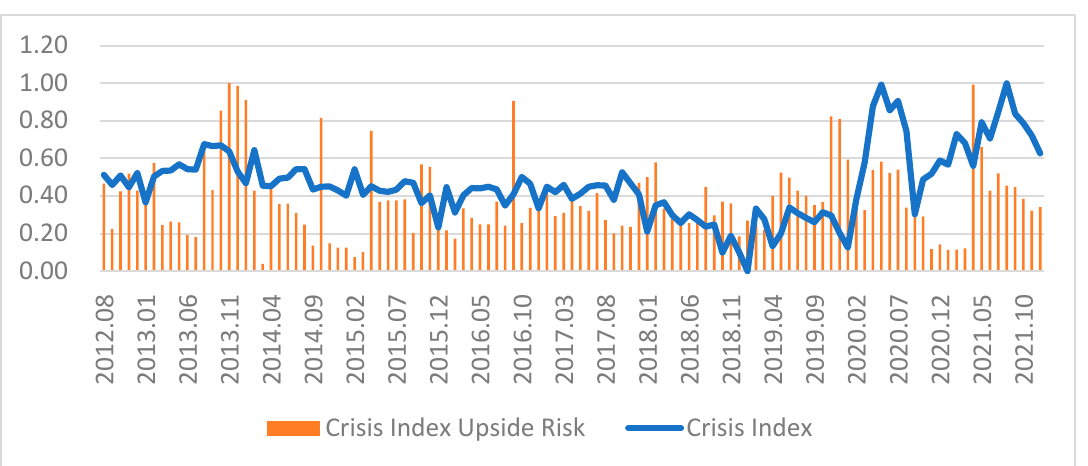
Figure 5. Comparison of Trends between Crisis Index and Momentum in the Energy Industry.